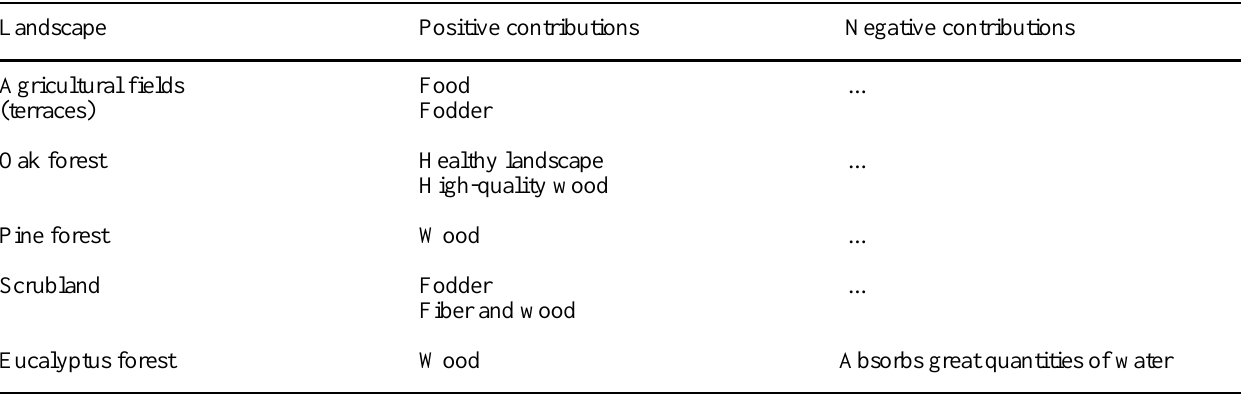
Table 5 . Results of the landscape scoring, presented by decreasing order of preference.